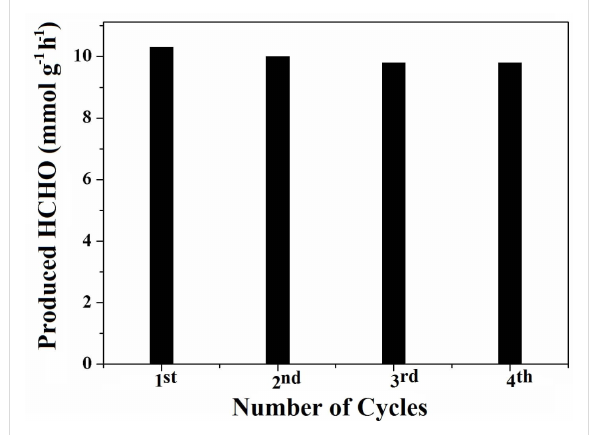
Figure 12: Photostability of the GCN-5 sample against the production of HCHO.